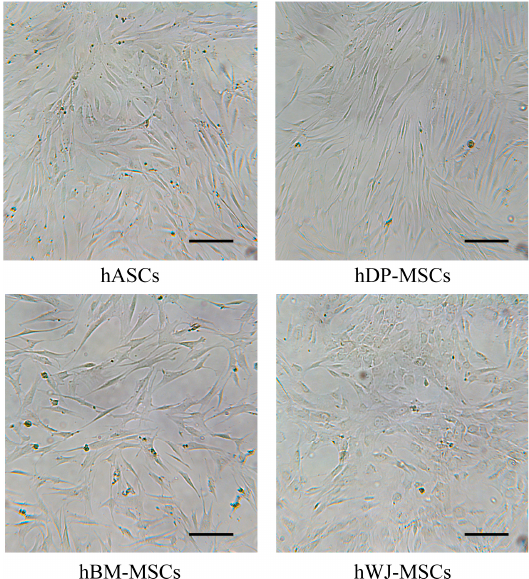
Figure 1. Representative images of hMSCs (culture passages 5th–7th) isolated from human adipose tissue (hASCs), dental pulp (hDP-MSCs), bone marrow (hBM-MSCs), and Wharton’s Jelly (hWJ-MSCs). Cells were analyzed for morphology under optical microscopy (40 × magnification and bright field illumination). Scale bar corresponds to 200 μ m.